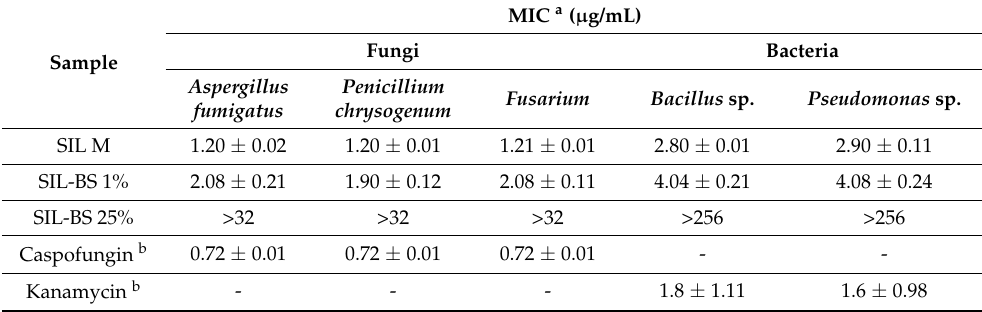
Table 6. The results of anti-microbial activity of the tested compounds SIL M and SIL